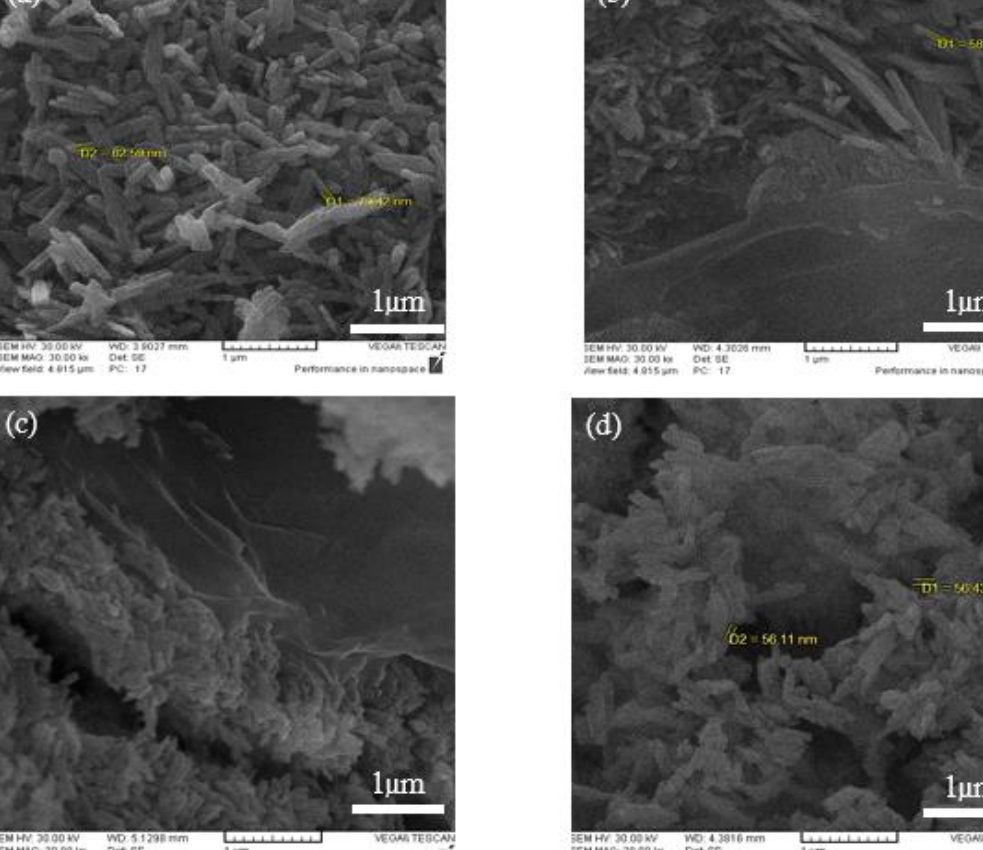
Fig. 4. SEM images of (a) the pure CdWO